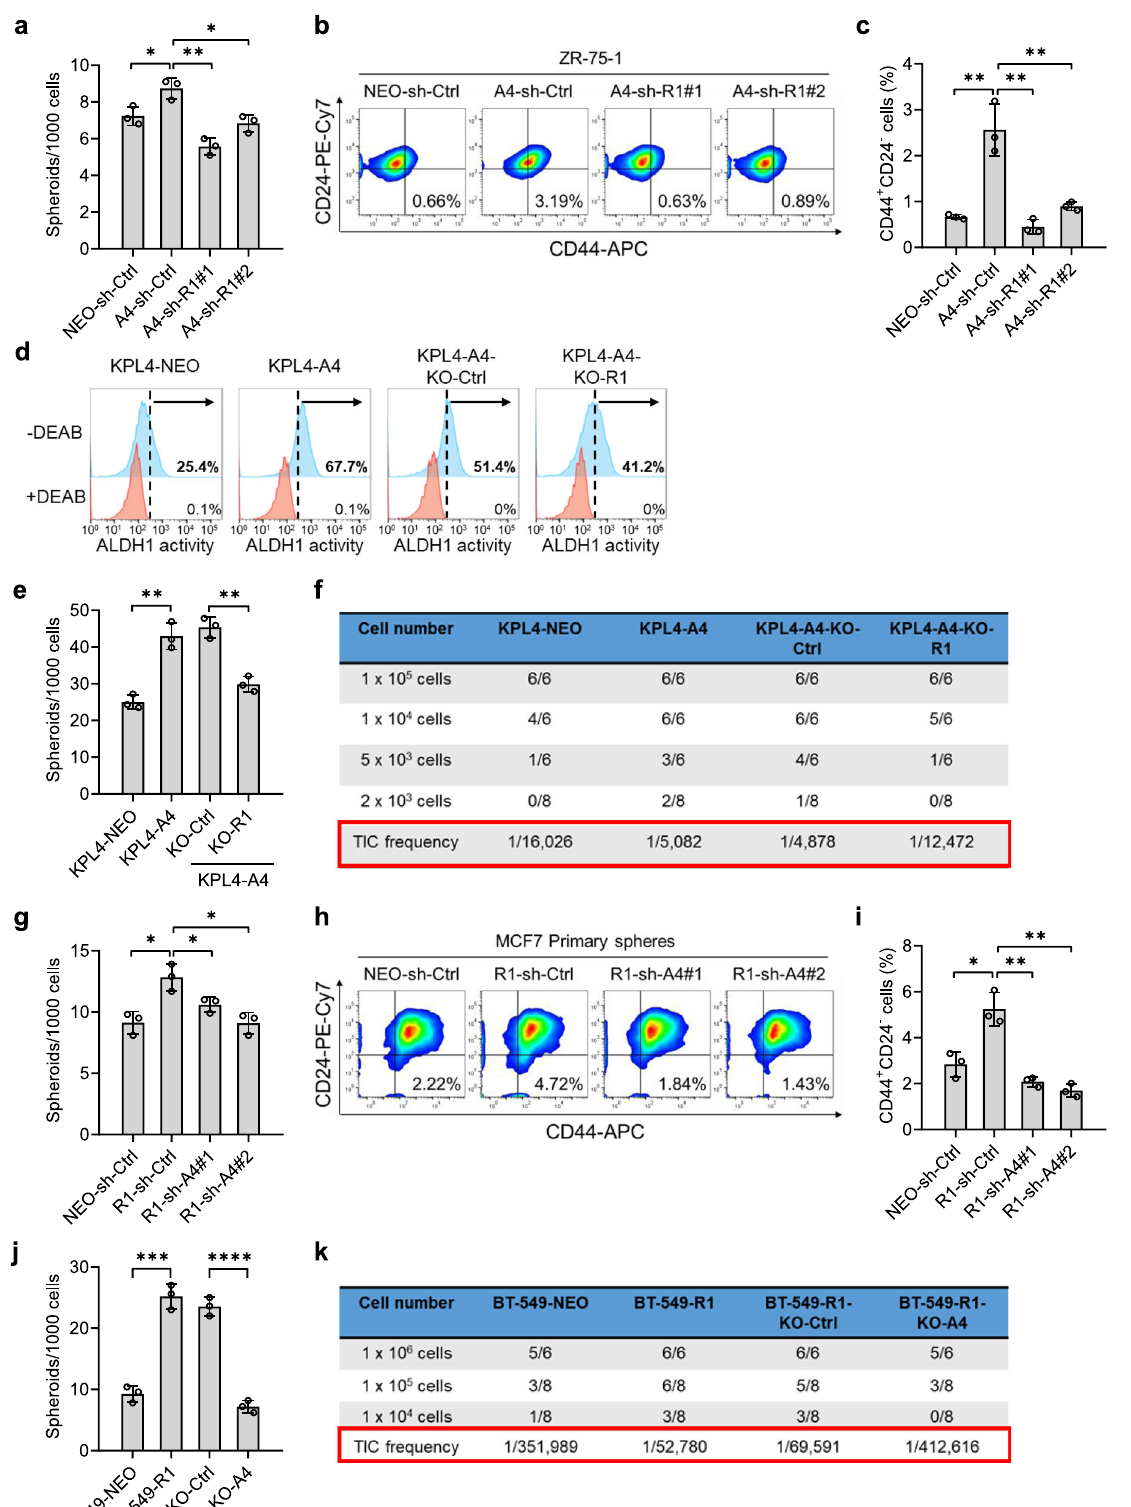
the pathological relevance of the hRNase 1 – EphA4 axis in tumor initiation with potential clinical implications for breast cancer